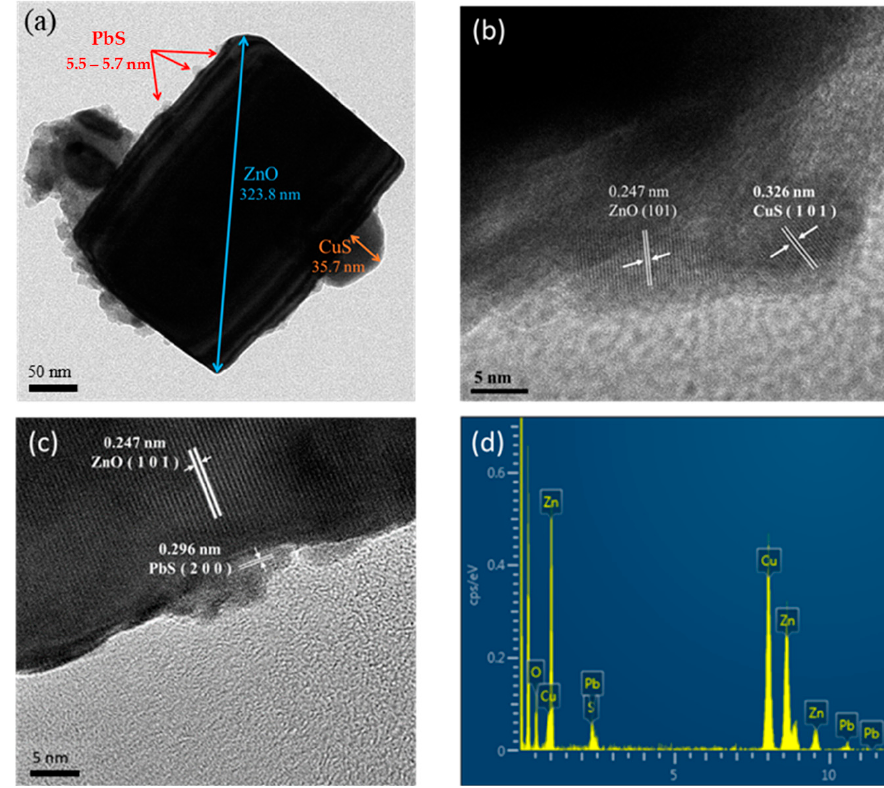
Figure 1. TEM analysis of CuS/PbS/ZnO heterojunction photocatalyst. ( a ) Analytical images of CuS/PbS/ZnO photocatalyst, ( b ) image analysis of the lattice spacing for CuS NPs loaded onto ZnO, ( c ) image analysis of PbS QDs and ZnO lattice spacing, and ( d ) EDX analysis of CuS/PbS/ZnO photocatalyst.